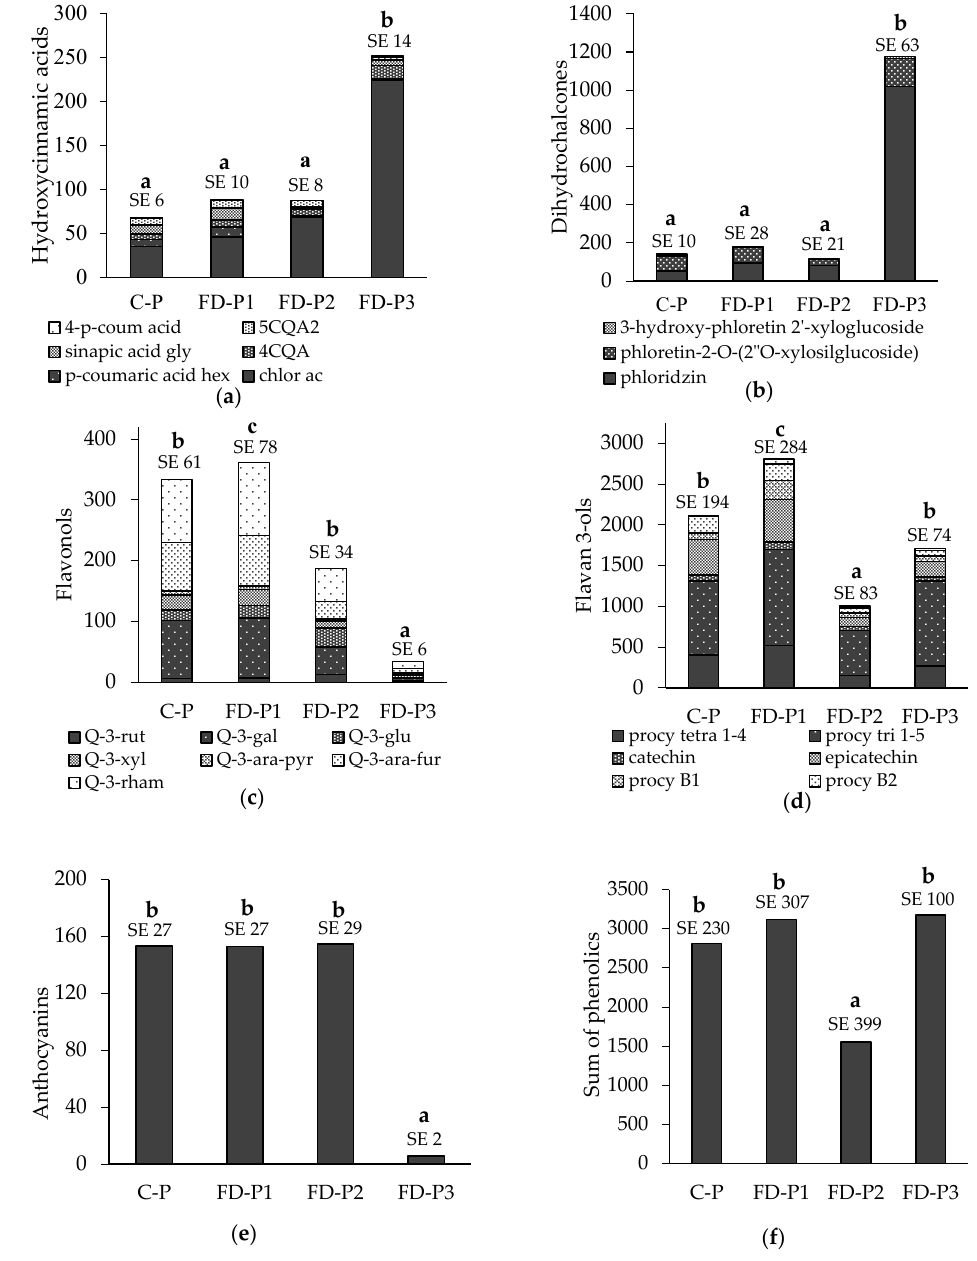
Figure 3. Content of individual phenolic compounds (mean ± SE in mg kg −1 fresh weight) shown in groups: ( a ) hydroxycinnamic acids (p-coumaric acid hex, p-coumaric acid hexoside; chlor ac, chlorogenic acid; 4CQA, 4-caffeoylquinic acid; 5CQA2, 5-caffeoylquinic acid 2; sinapic acid gly, sinapic acid glycoside; 4-O-p-coum ac, 4-p-coumaroylquinic acid); ( b ) dihydrochalcones (3-hydroxy-phloretin-2 ′ -O-xyloglucoside; phloretin-2-O-(2 ″ O-xyloglucoside); phloridzin); ( c ) flavonols (Q-3-rut, quercetin 3-rutinoside; Q-3-gal, quercetin 3-galactoside; Q-3-glu, quercetin 3-glucoside; Q-3-xyl, quercetin 3-xyloside; Q-3-ara-pyr, quercetin 3-arabinopyranoside, Q-3-ara-fur, quercetin 3-arabinofuranoside; Q-3-rham, quercetin 3-rhamnoside); ( d ) flavan-3-ols (procy B1, procyanidin dimer B1; procy B2, procyanidin dimer B2; procy tri 1–5, five procyanidin trimers; procy tetra 1–4, four procyanidin tetramers; catechin; epicatechin); anthocyanins (cyanidin-3-galactoside); ( e ) anthocyanins; and ( f ) the sum of all phenolics in the apple peel of un- damaged apples (C-P) and the frost-damaged apples: healthy peel (FD-P1), discoloured boundary (FD-P2), corky peel (FD-P3). Different letters above columns denote statistical differences between treatments (the Duncan test. p < 0.05).